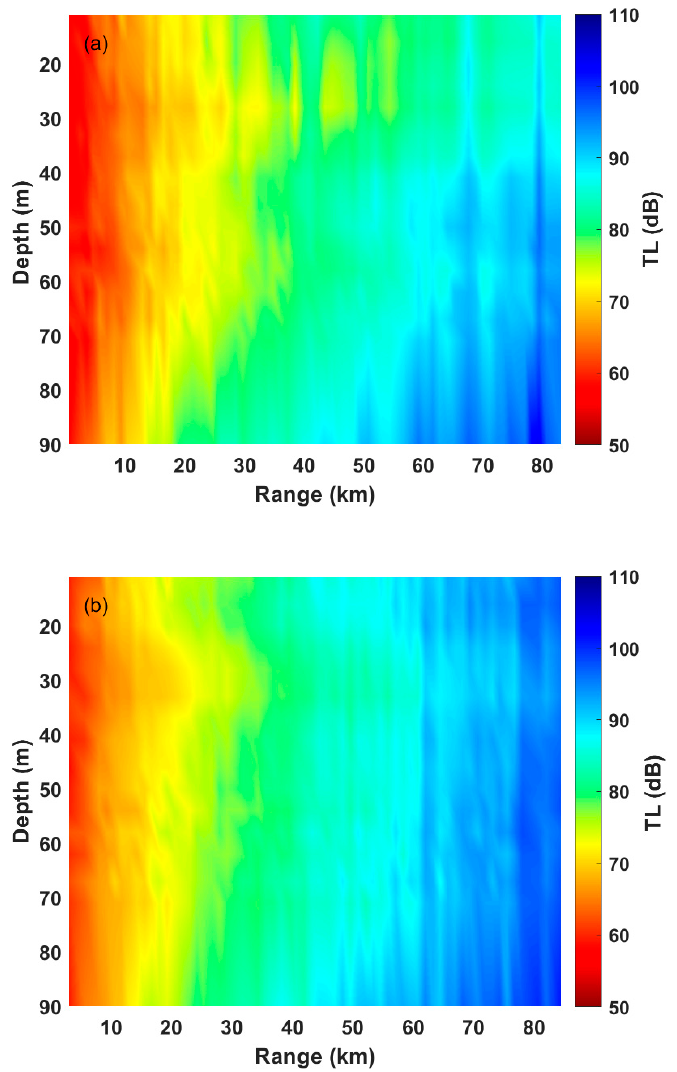
Figure 6. The experimental TLs at all receivers for T1O ( a ) and T3O ( b ), for the central frequency 1000 Hz and the source depth 7 m.